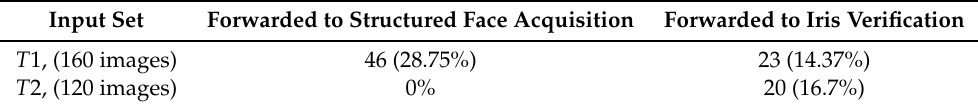
Table 2. Solving rates for genuine subjects, in unsolvable state.